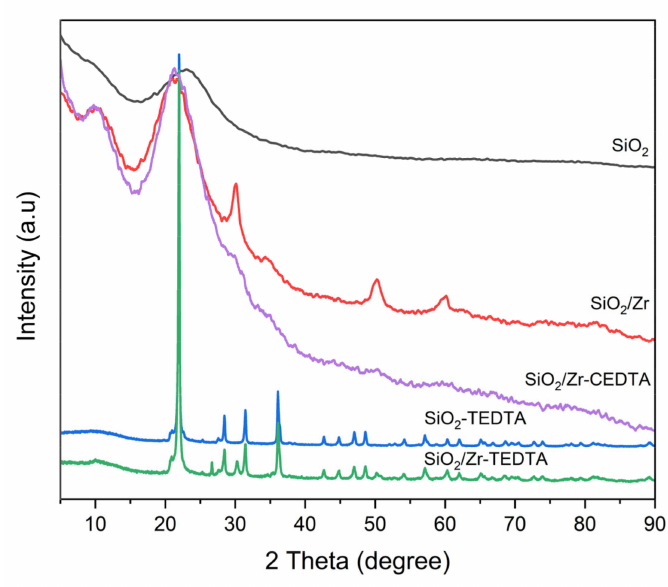
Figure 1. XRD diffraction of SiO 2 , SiO 2 /Zr, SiO 2 /Zr-CEDTA, SiO 2 -TEDTA, and SiO 2